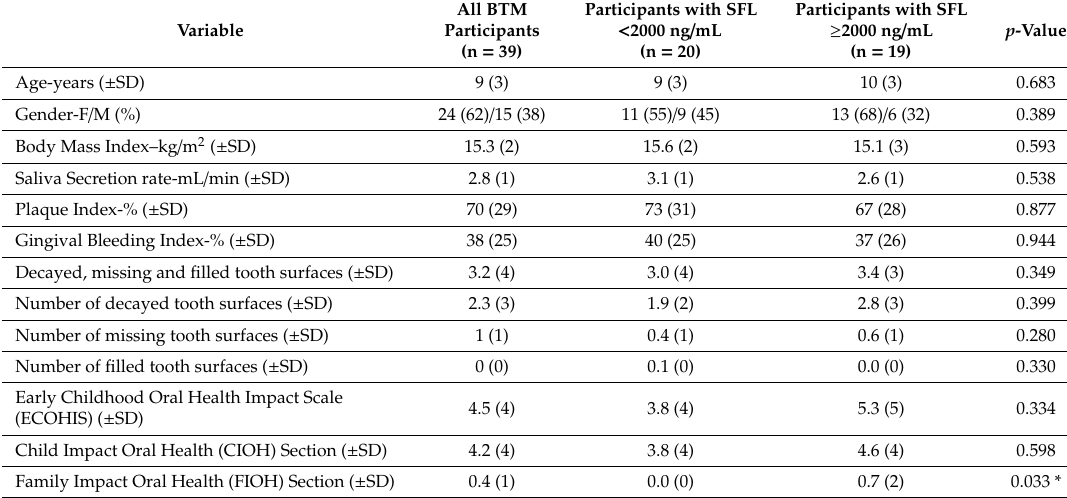
Table 1. Demographic variables, oral health parameters and section and overall scores for the Early Childhood Oral Health Impact Scale (ECOHIS) in all participants with β -thalassemia major (BTM) (n = 39), includingthosewithserumferritinlevel(SFL) < 2000ng / mL(n = 20)andwithSFL ≥ 2000 ng / mL (n = 19). All BTM Participants with SFL Participants with SFL < 2000 ng / mL ≥ 2000 ng / mL Variable Participants (n = 39) (n = 20) (n =